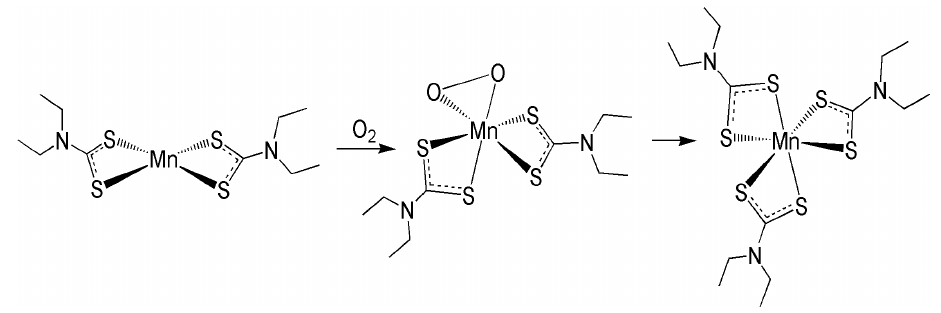
Figure 2. Hypothetical scheme of the conversion of [MnL 2 ] into [MnL 3